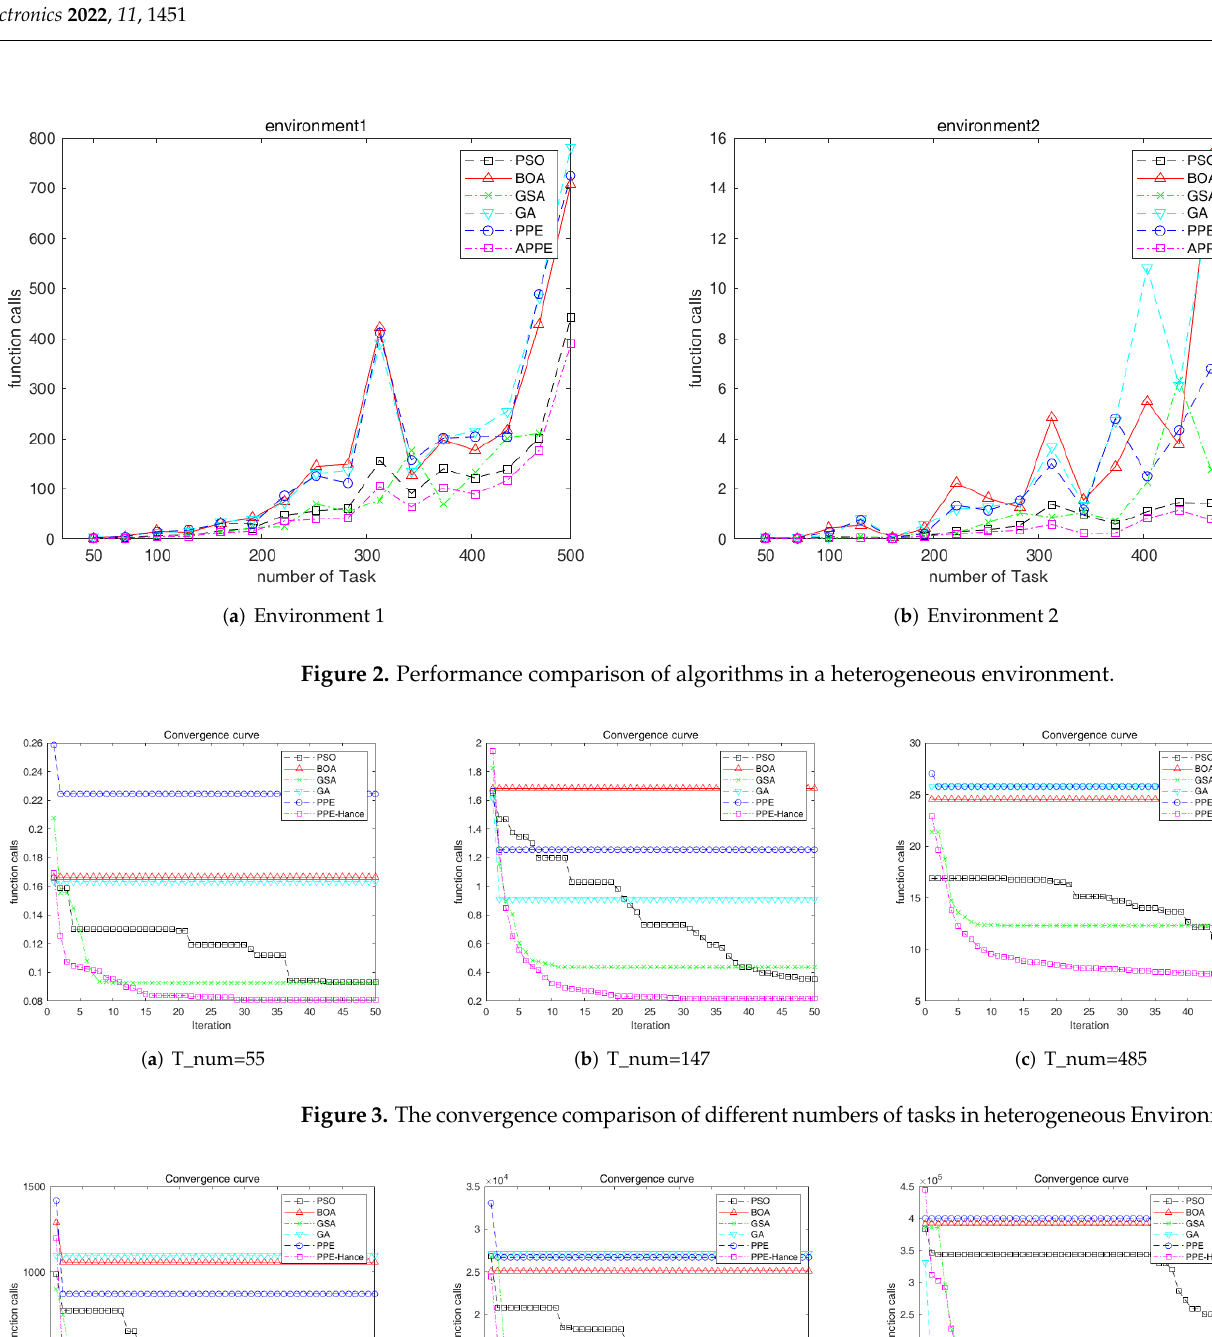
Figure 3. The convergence comparison of different numbers of tasks in heterogeneous Environment 1